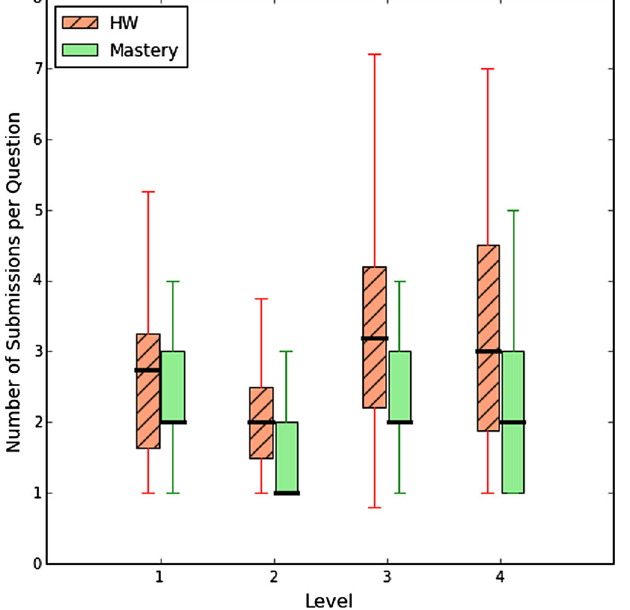
1. Box-and-whiskers plot of time spent on each level in minutes. Median values are reported in the black line in the center of each box, and the boxes represent the interquartile range (IQR ¼ Q 3 -Q 1 ). Whiskers represent the most extreme value, for example, for the top whisker, within 1 . 5 × IQR þ Q 3 . Outliers are not shown. Groups spent similar amounts of time on each